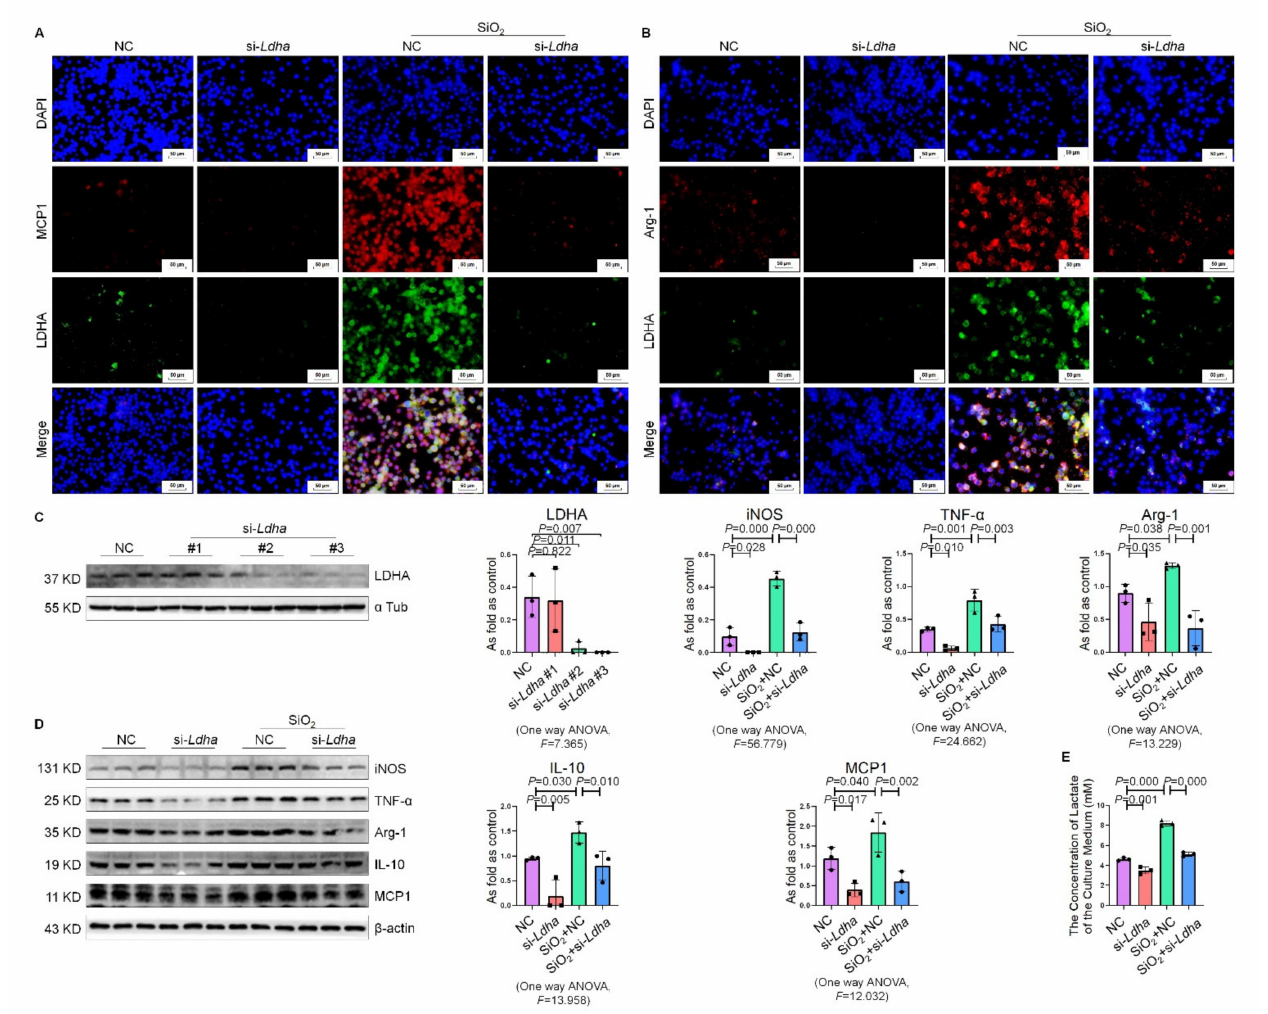
Figure 6. Knockdown of Ldha inhibits silica-induced macrophage activation. ( A ) The co-expression of MCP1 and LDHA in NR8383 cells was measured by IF staining, bar = 50 µ m. ( B ) The co-expression of Arg-1 and LDHA in NR8383 cells was measured by IF staining, bar =50 µ m. ( C ) Transient transfection of siRNA- Ldha sequence in macrophages. ( D ) The protein levels of iNOS, TNF- α , Arg-1, IL-10, and MCP1 in NR8383 cells transfected with siRNA- Ldha and treated with or without SiO 2 were measured by Western blotting. Data are presented as the mean ± SD. n = 3 per group. ( E ) The lactate content in the culture medium was detected using a lactate assay kit. NC: negative control; si- Ldha : siRNA- Ldha